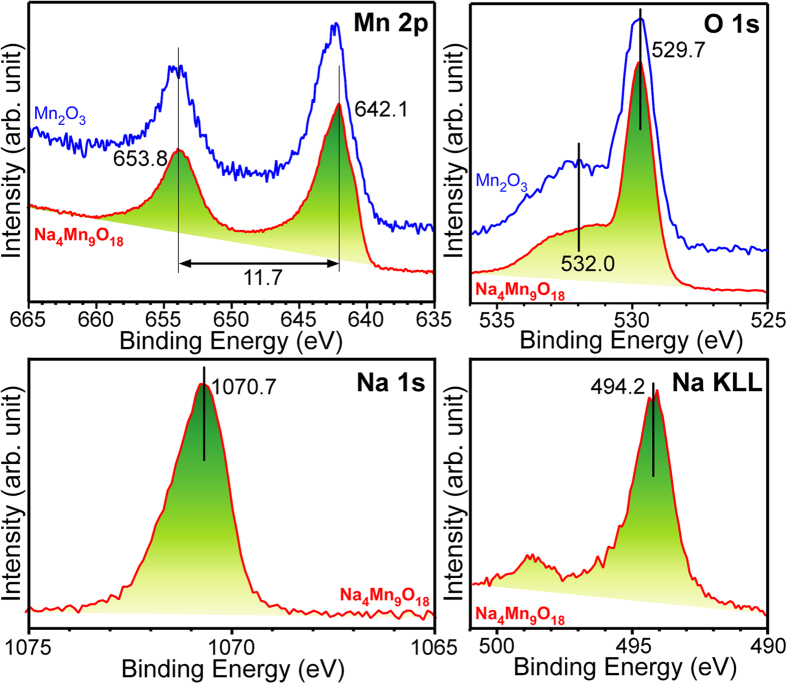
High resolution Mn 2p, O1s, N 1s, and Na KLL photoelectron spectra of the Mn2O3 particles and Na4Mn9O18 nanowires.